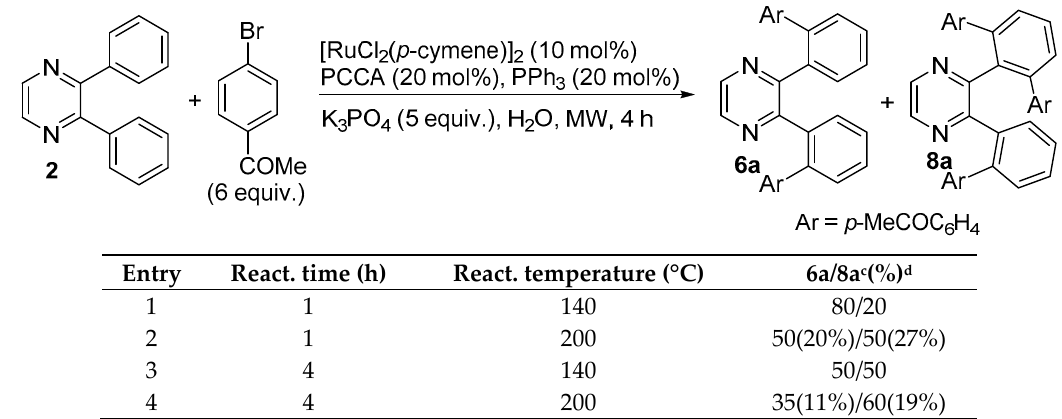
a Reaction conditions: 1 (0.25 mmol), 4-bromoacetophenone (1.5 mmol), [RuCl 2 ( p -cymene)] 2 (0.025 mmol), PCCA (0.05 mmol), PPh 3 (0.05 mmol), K 3 PO 4 (1.25 mmol), H 2 O (1 mL), MW, argon.